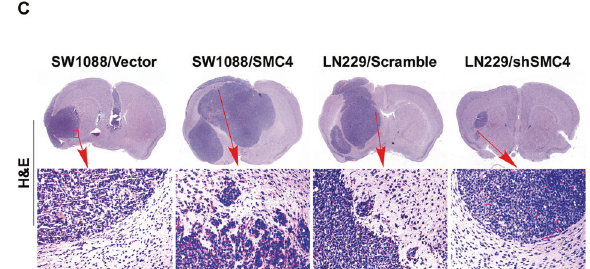
Fig. 5 SMC4 accelerates glioma cell tumorigenicity in vivo. c Intracranial brain tumor xenograft model in nude mice; representative images of tumors from each group are shown. Hematoxylin – eosin (H&E, lower panel magni fi cation, × 100) staining demonstrated that SMC4 overexpression induced the aggressive phenotype of glioma cells in vivo, whereas SMC4 suppression inhibited